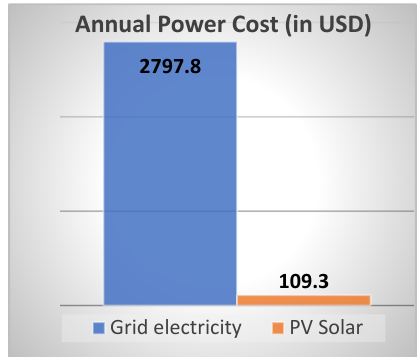
Figure 1. Annual power cost.